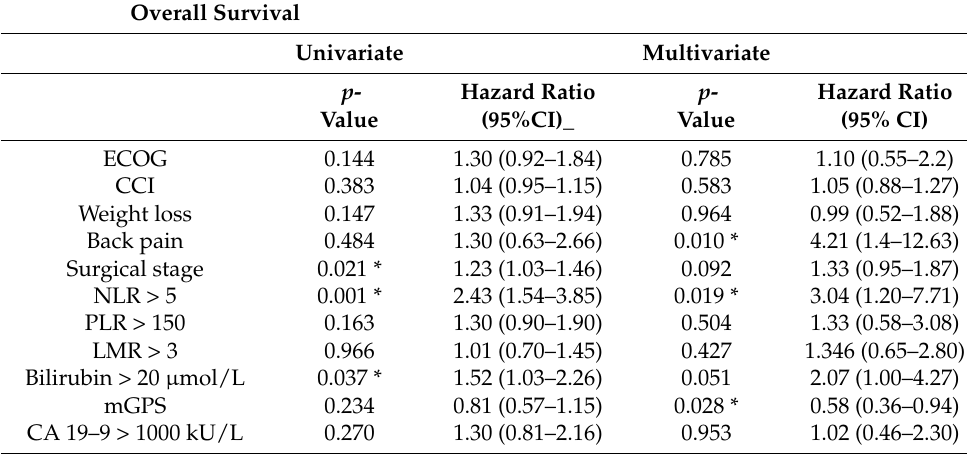
Table 4. Clinical and inflammatory prognostic markers of overall survival.